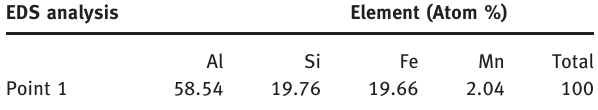
Table 3: EDS quantitative analysis of point 1 located in Figure 3(a). EDS analysis